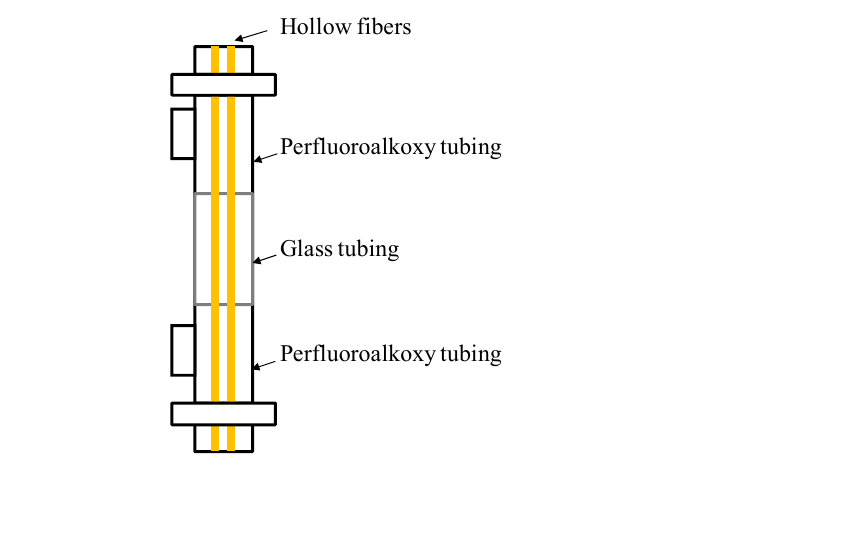
Figure A1. A schematic diagram of membrane modules for in situ